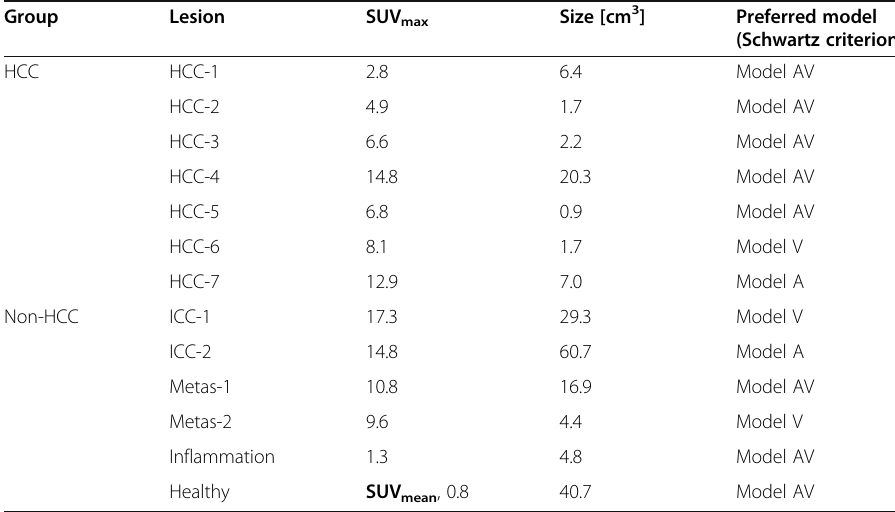
Table 1 Standardized uptake value (SUV) and volume size of all investigated lesions, including the preferred model for each lesion. For the healthy region, the average overall regions is presented for SUV mean , size, and preferred model